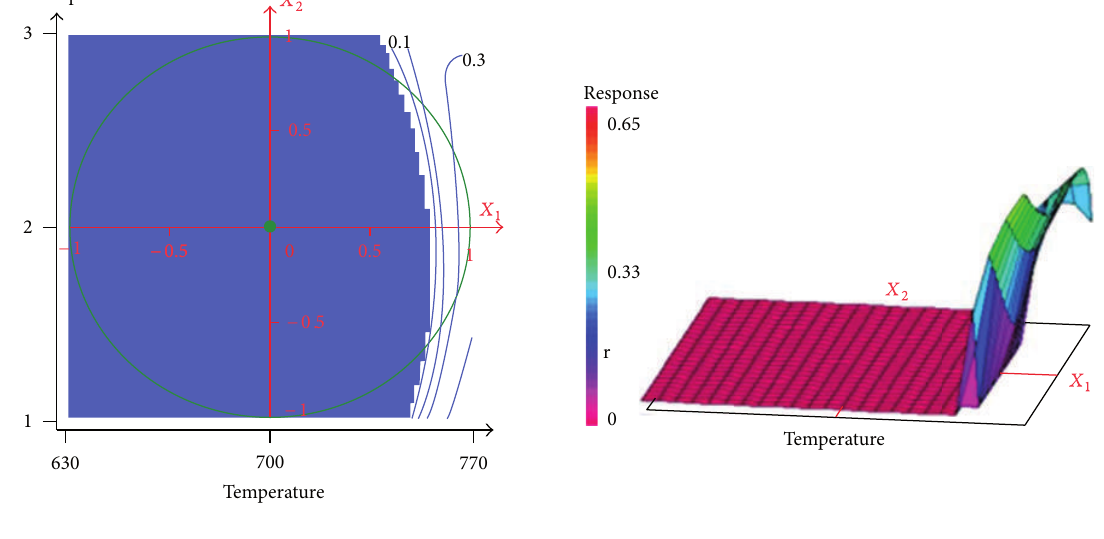
F 4: Variation of the function of desirability as a function of both activation temperature and impregnation